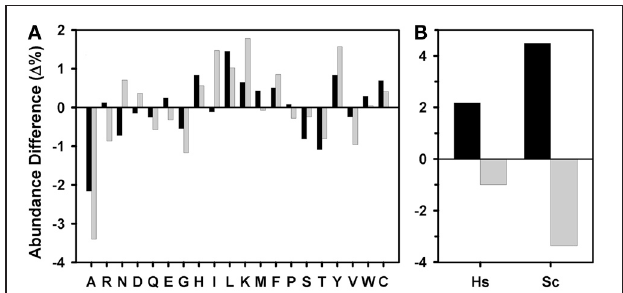
FIGURE 4 | Amino acid composition of kinase domains. (A) Differential amino acid composition of the human (black) and yeast (gray) kinase domains and (B) differential proportion of residues with high (black) and low (gray) β -aggregation propensity in human (Hs) and yeast (Sc) kinase domains, both relative to the amino acid composition of the Swiss-Prot database ensemble (release